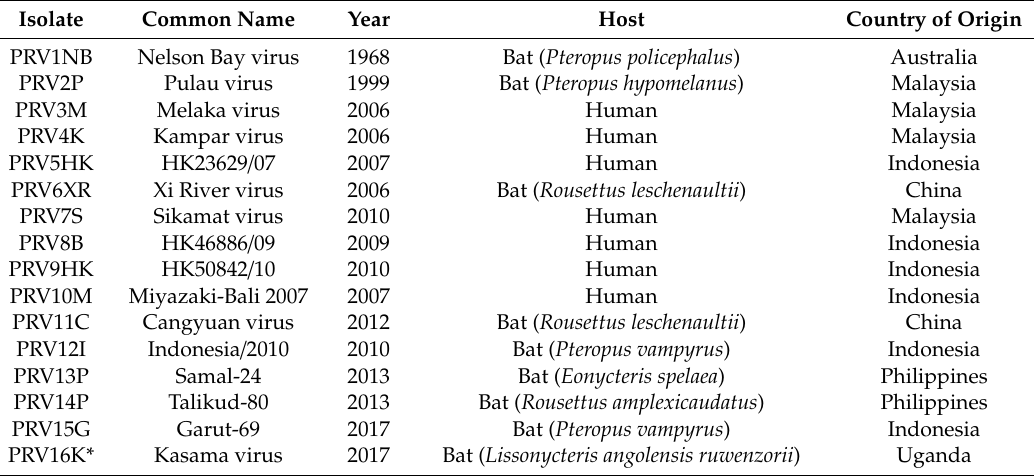
Table 1. Pteropine orthoreoviruses detected in bats and